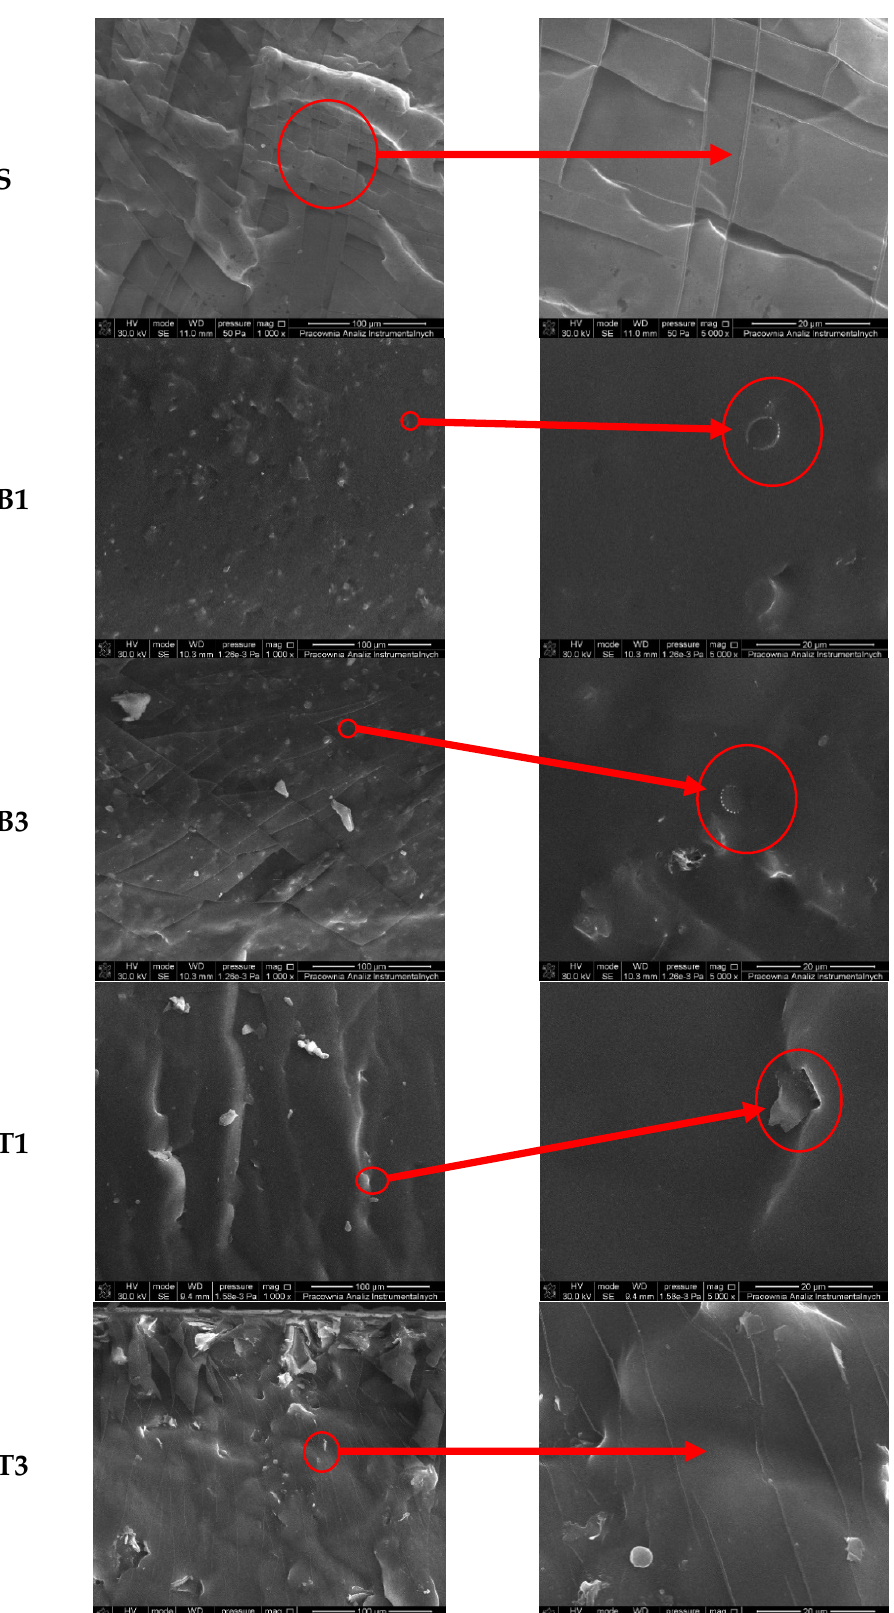
Figure 5. Cross sections of Sylgard and obtained composites.